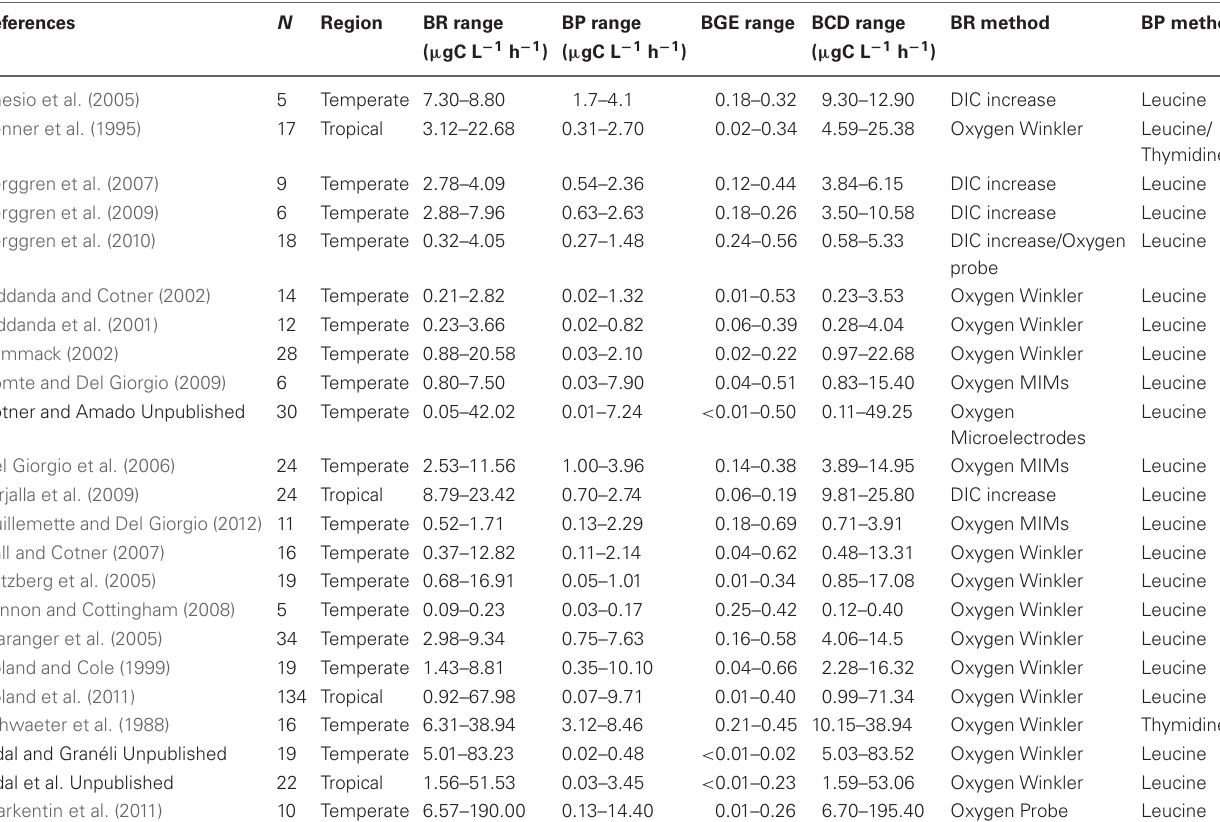
Table 1 | Database used in the analysis with the literature extracted and novel